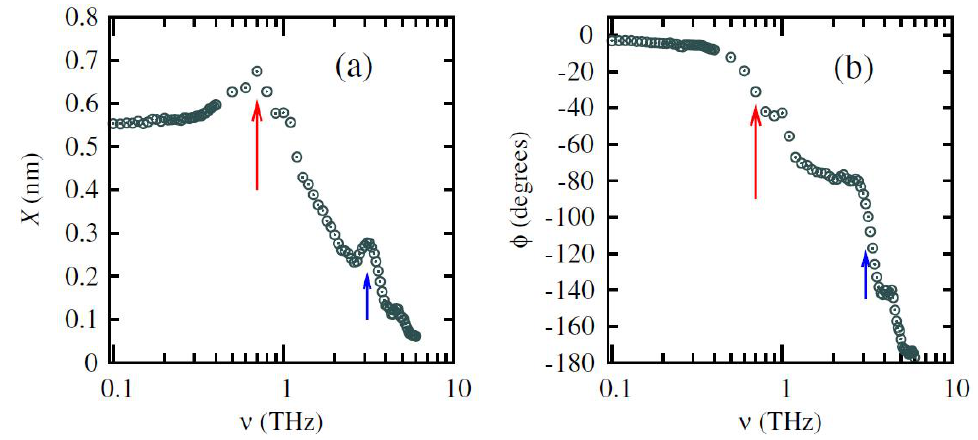
Figure 19. Frequency-dependent response of a nanowall to the electric field in a PZT film. The arrows indicate positions of the peaks. (Reprinted with permission from [280]; Copyright 2011 by the American Physical